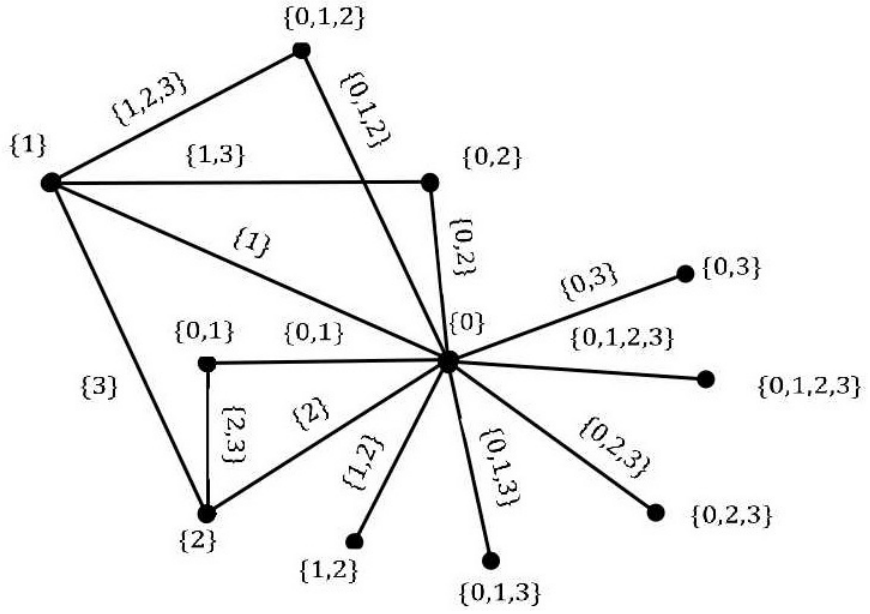
Figure 2. A TIASS-graph with respect to the ground set X = { 0 , 1 , 2 , 3 }